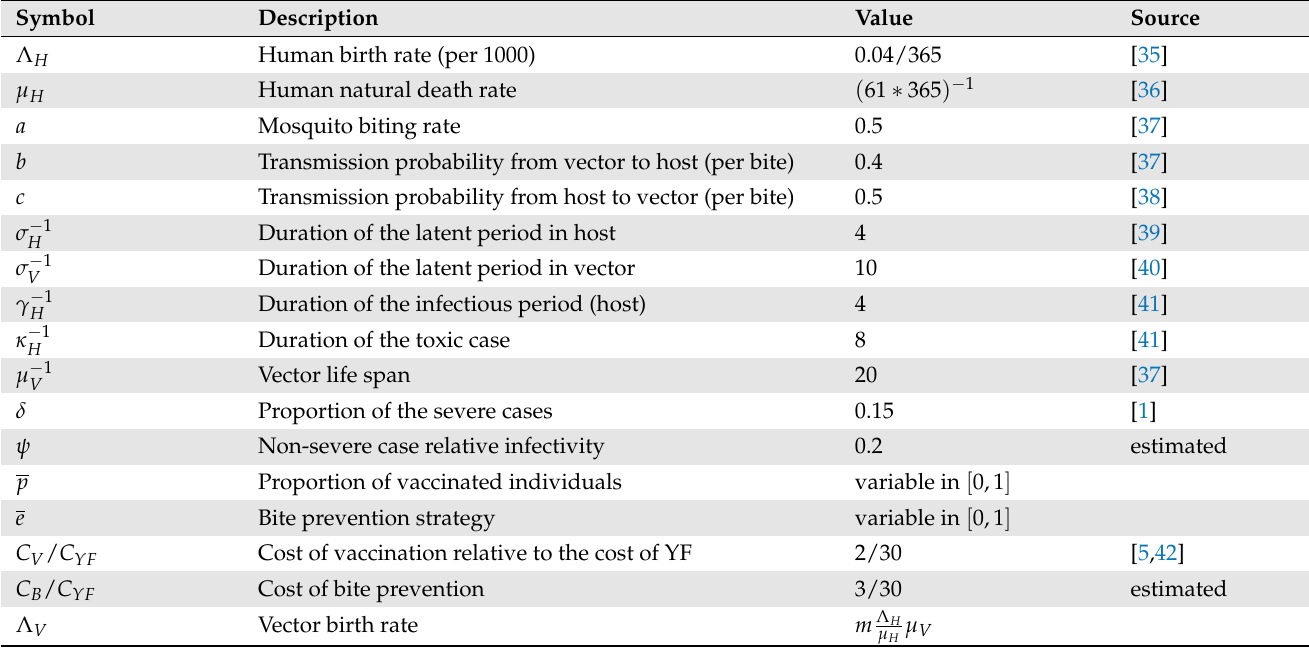
Table 1. Model parameters. The per capita rates are per day. The times are in